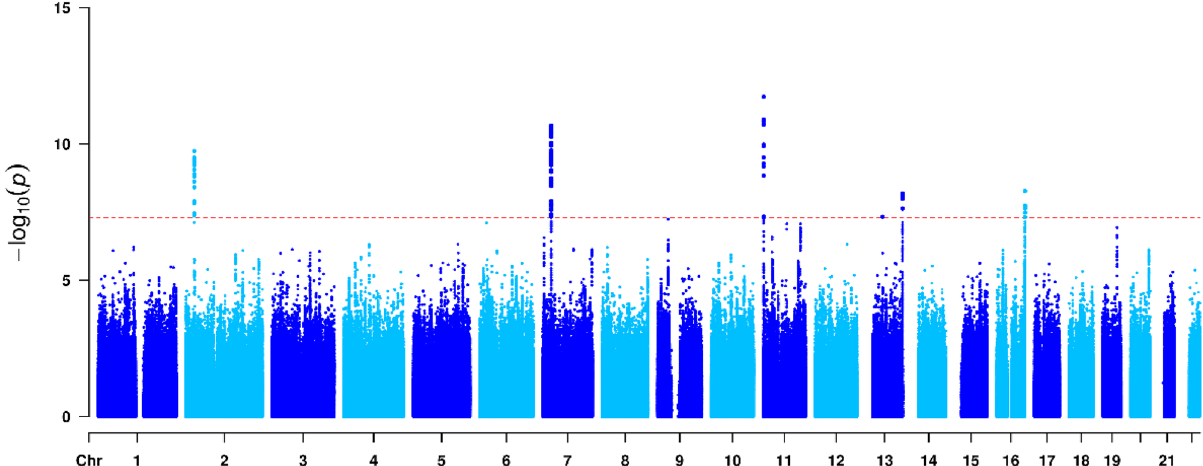
Figure 4. Manhattan plot visualizing genome-wide results from the vQTL analysis of DBP. Dots denote the SNPs in the genome-wide vQTL analysis, whose P values on a negative log 10 scale are plotted against their physical positions. The dashed line represents the genome-wide significance level (P = 5 × 10 −8 ).